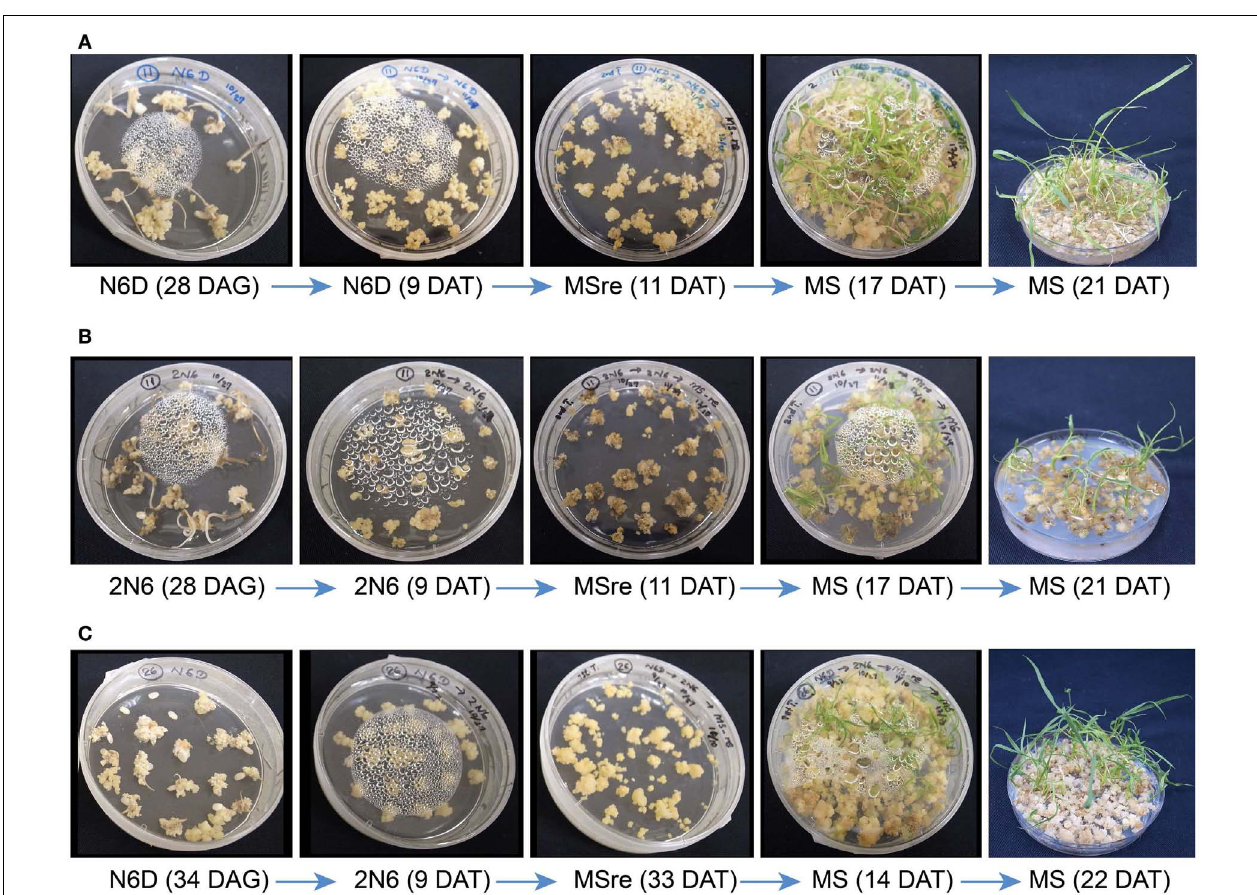
N6D-2N6-MSre-MS medium combination. See “Media Used for Callus Induction and RegenerationTest” in the Section “Materials and Methods” for medium combination. DAG, days after germination; DAT, days after transferring.The numerals shown inside parentheses mean DAG or DAT when photograph was taken on each